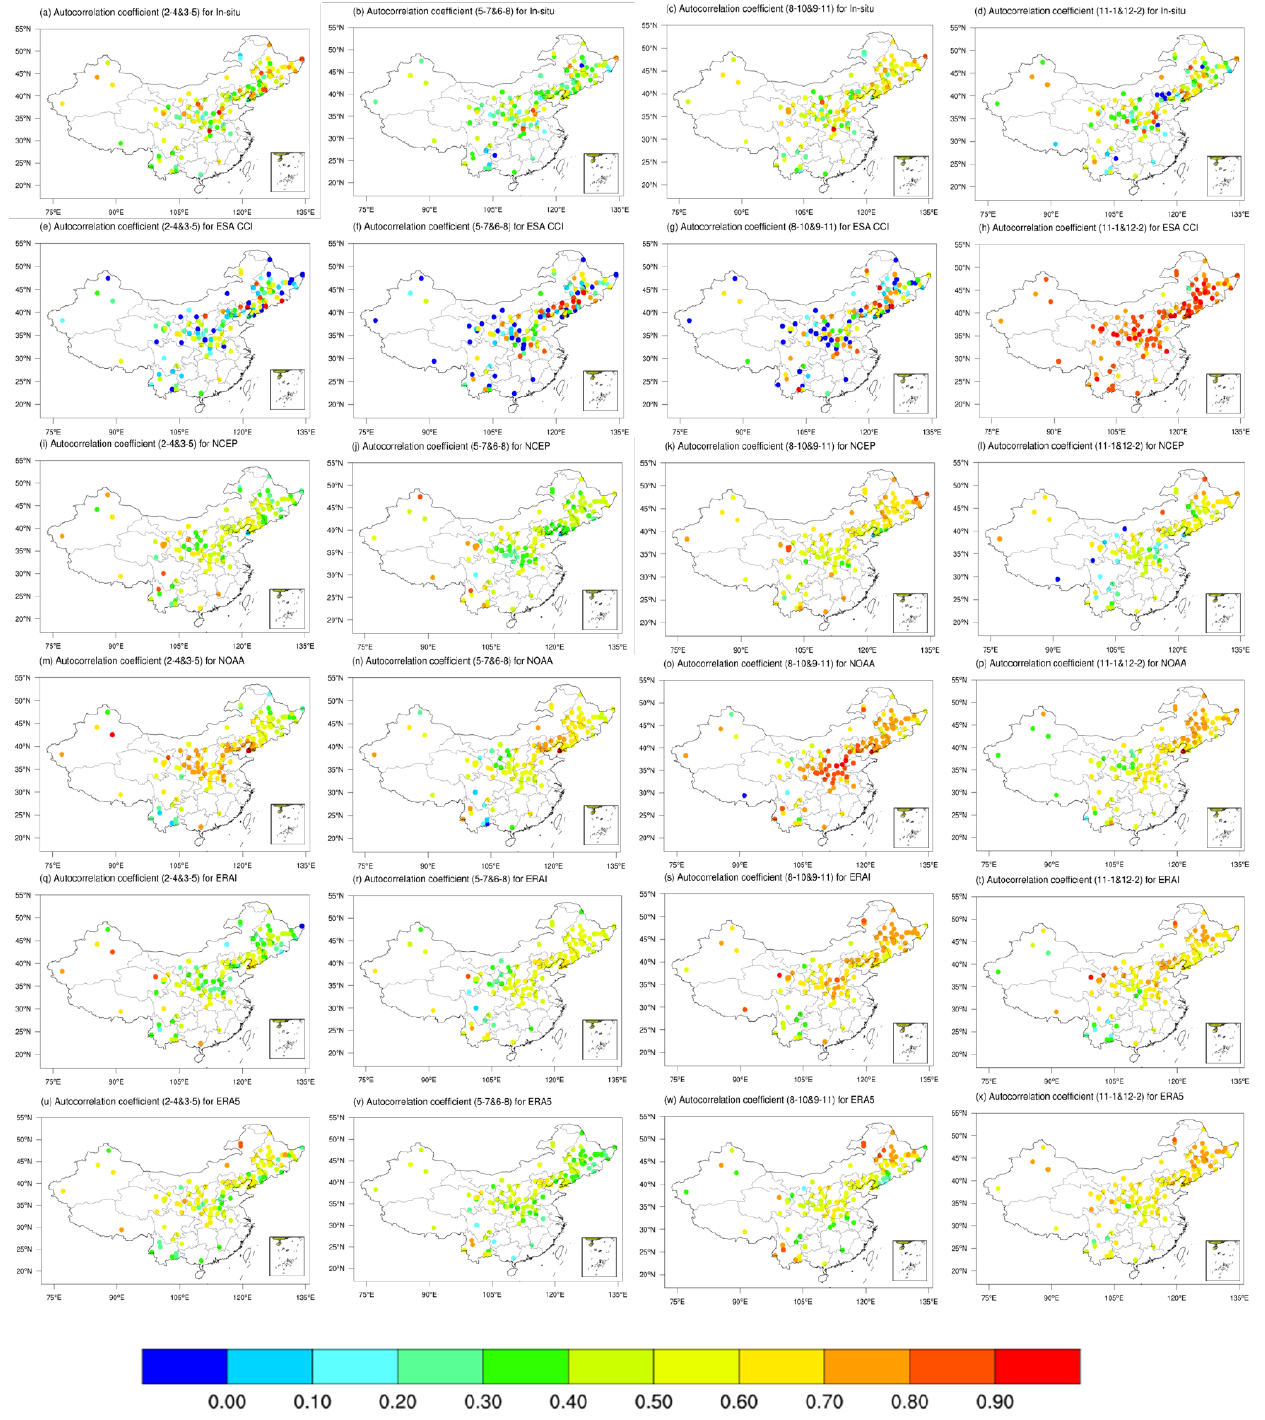
Figure 7. Distribution of the autocorrelation coefficient of SM in the following seasons: (a, e, i, m, q, u) FMA (February–April) and MAM (March-May), (b, f, j, n, r, v) MJJ (May–July) and JJA (June–August), (c, g, k, o, s, w) ASO (August–October) and SON (September– November), and (d, h, l, p, t, x) NDJ (November–January) and DJF (December–February) for (a–d) in situ, (e–h) ESA CCI, (i–l) NCEP, (m–p) NOAA, (q–t) ERA-Interim (ERAI), and (u–x) ERA5.